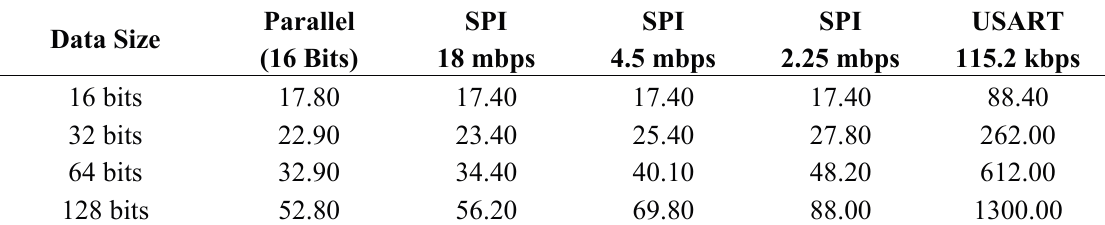
Table 4. Processing time in monitor node for each event log